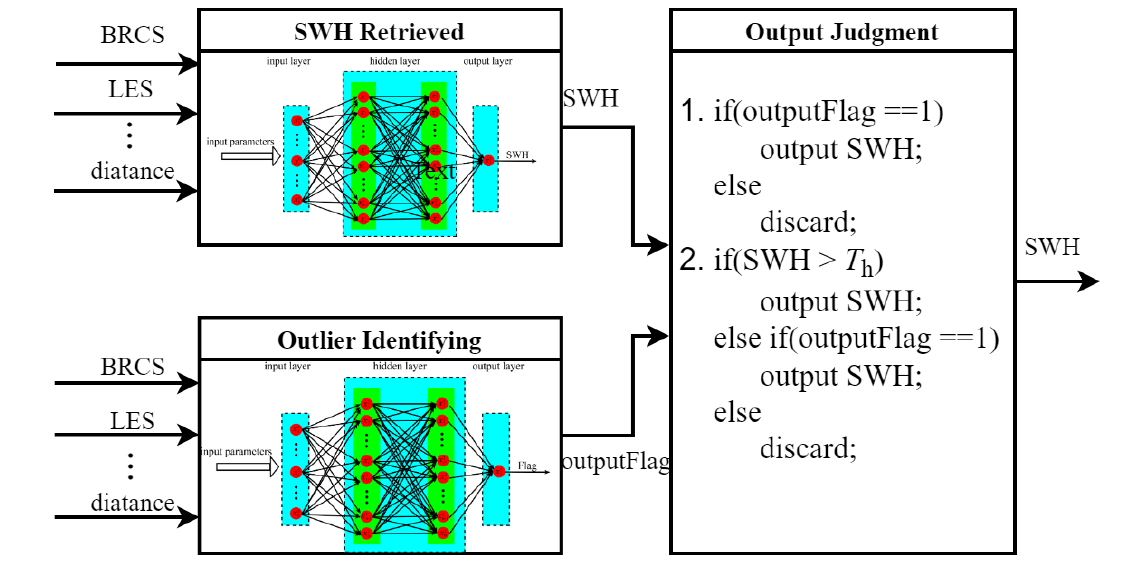
Figure 17. Combined framework of SWH retrieval and outlier